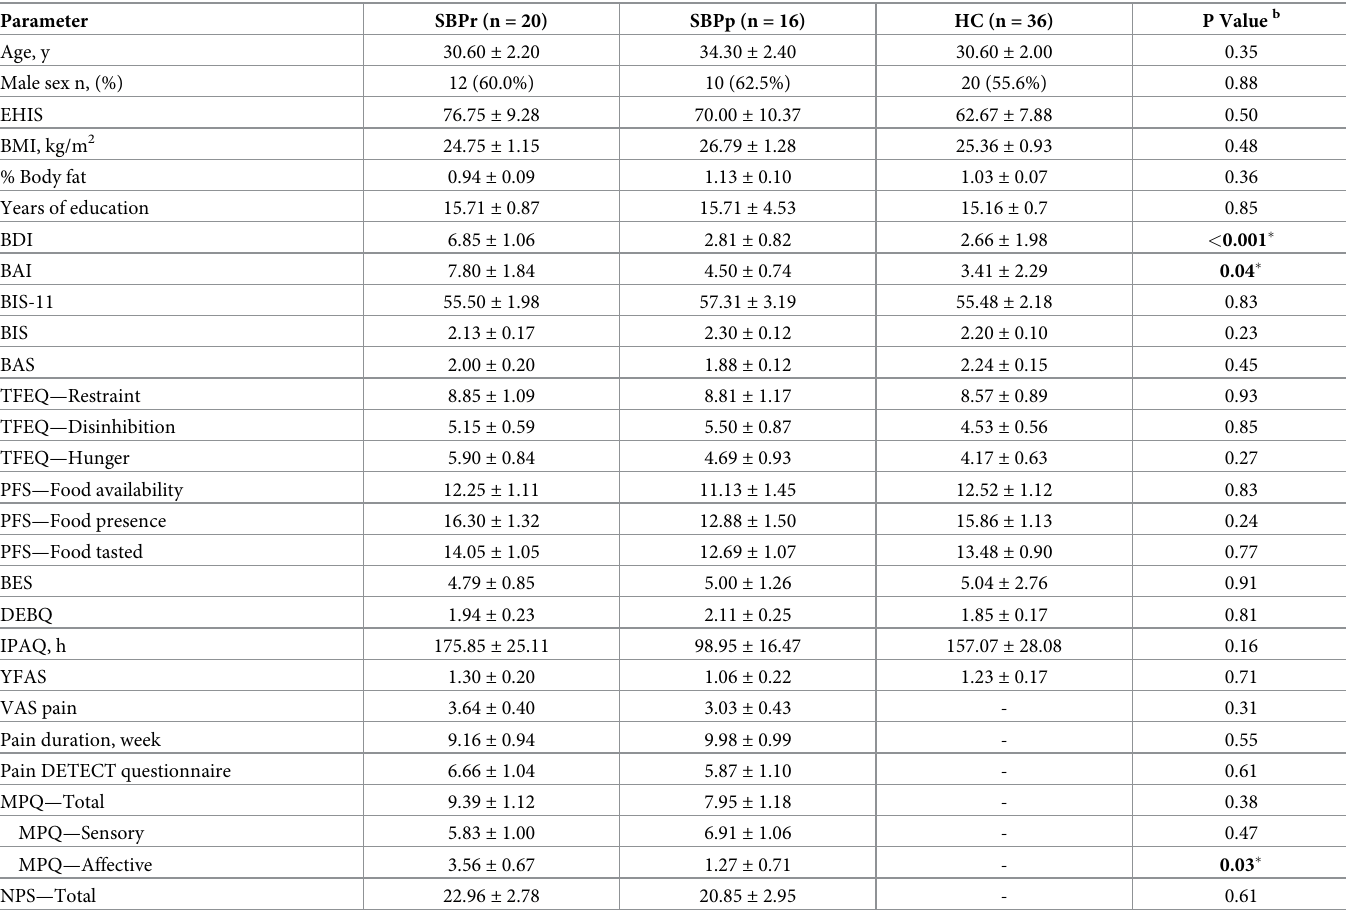
Table 2. Demographic and clinical characteristics of SBP patients at baseline a